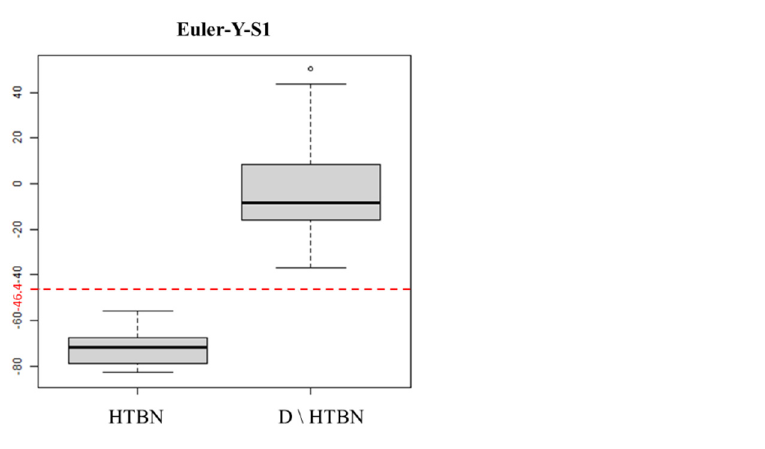
Figure 6. Boxplots of the Euler − Y kinematic values collected from the first sensor for HTBN and the other kinds of plank techniques (D\HTBN), where the values in the y − axis are computed from (1) and the circle denotes a potential outlier in the D\HTBN group.